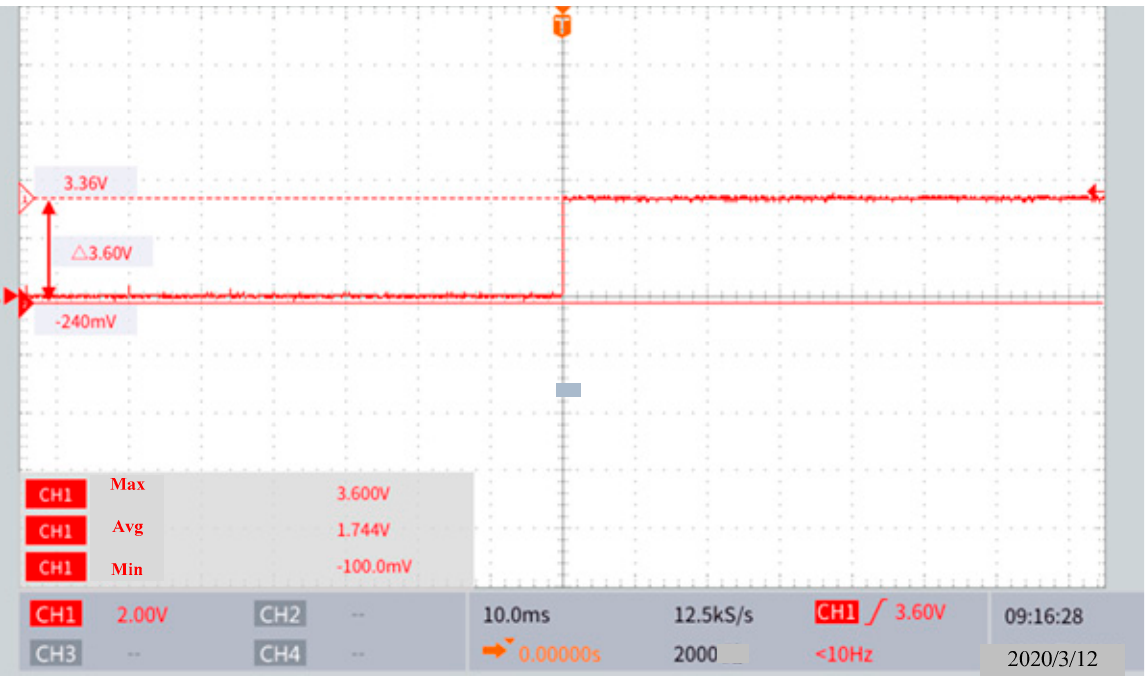
Figure 16. Output data of PIR.